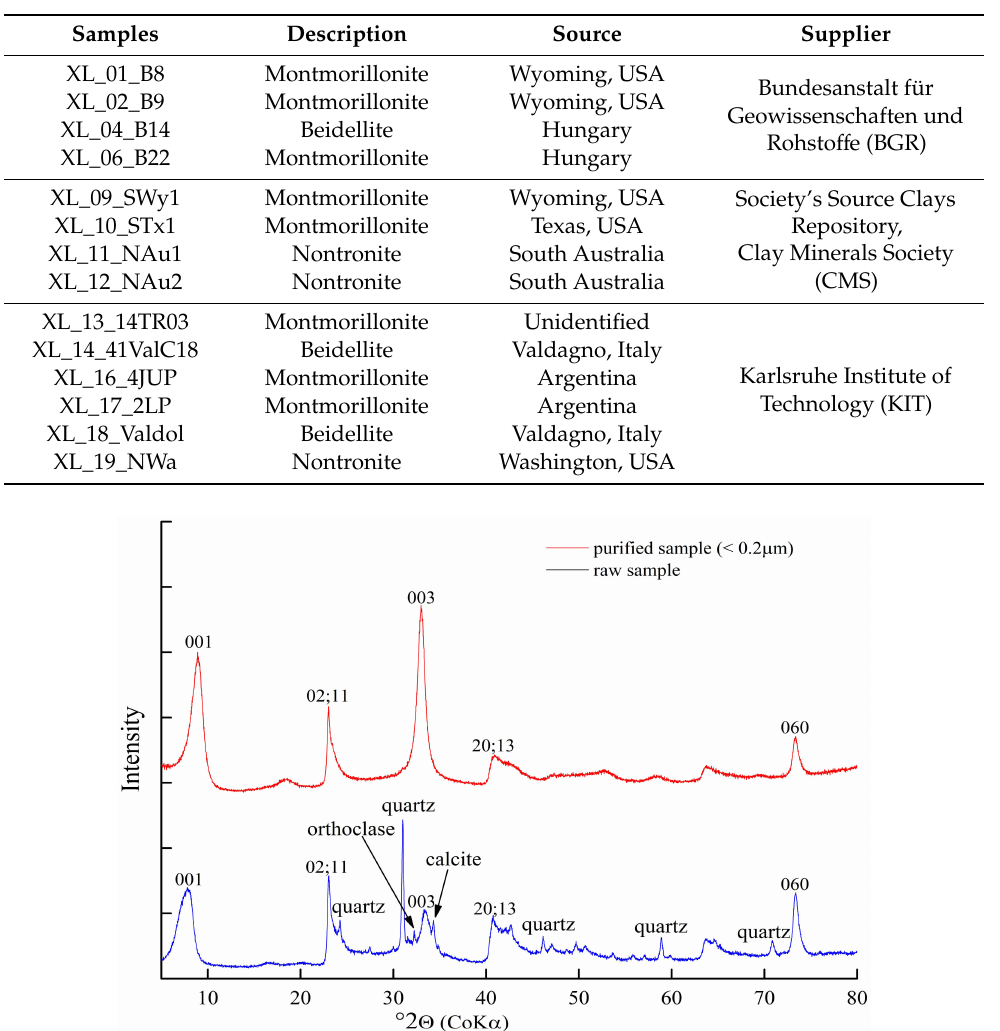
Table 1. Origin of samples.